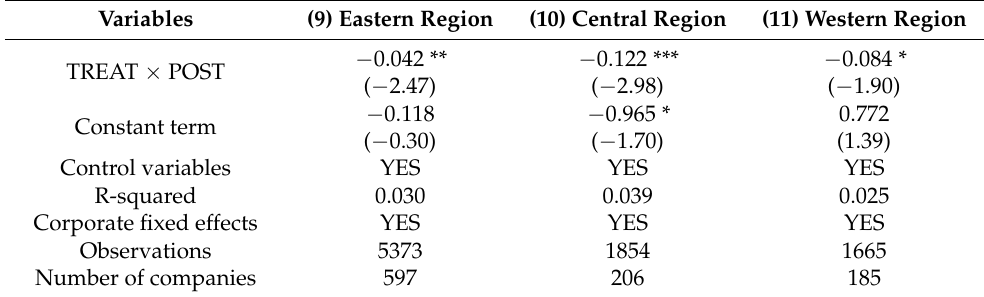
Table 6. Results of regional heterogeneity test.